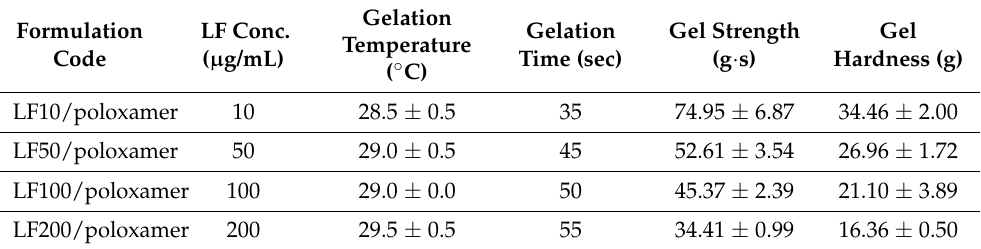
Table 2. Sol-to-gel transition temperature, time and mechanical properties of developed poloxamer gel formulation loaded with LF. Poloxamer composition: P407 25% w / w and P188 17% w / w . Data presented as the mean ± SD ( n =